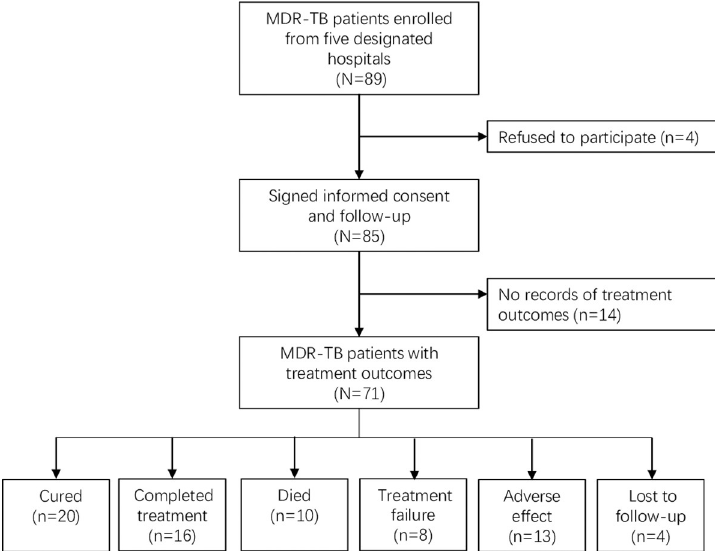
Fig 1. Eligibility and enrollment of study subjects MDR-TB: multidrug-resistant